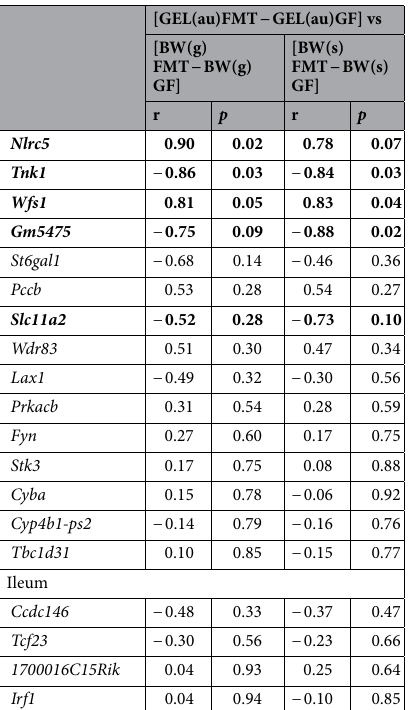
Table 2. Host genes associated with gut microorganism-mediated weight regulation. The correlation between differentially expressed genes (DEGs) common across six different diet groups between germ-free mice (GF) and fecal microbiota-administered mice (FMT) and body weight (BW) is expressed by the Pearson’s correlation coefficient (r) and associated p -value ( p ). The genes in bold text are with |r| > 0.7. iWAT, inguinal white adipose tissue; eWAT, epididymal white adipose tissue; BAT, brown adipose tissue; GEL(au)FMT, gene expression level (arbitrary unit) of FMT; GEL(au)GF, gene expression level (arbitrary unit) of GF; BW(g)FMT, absolute body weight (gram) of FMT; BW(g)GF, absolute body weight (gram) of GF; BW(s)FMT, increasing ratio of body weight (slope) of FMT; and BW(s)GF, increasing ratio of body weight (slope) of